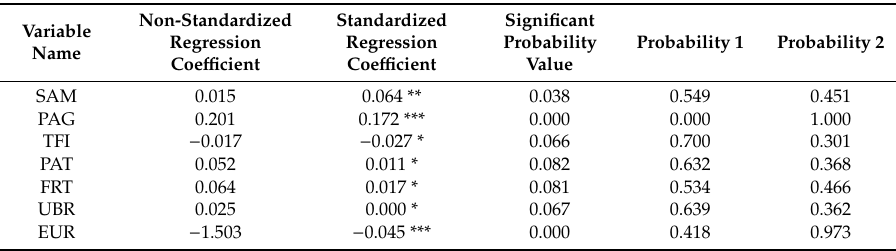
Table 12. The results of QAP regression